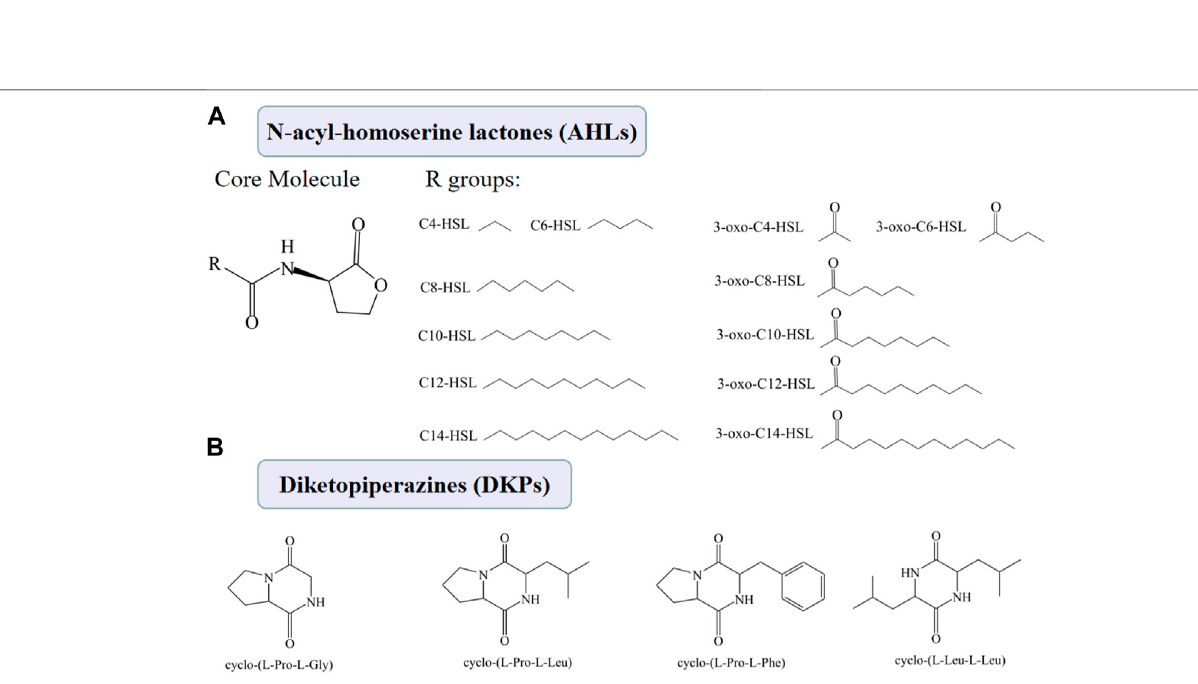
FIGURE4 | Chemical structures of AHLs (A) and DKPs (B)